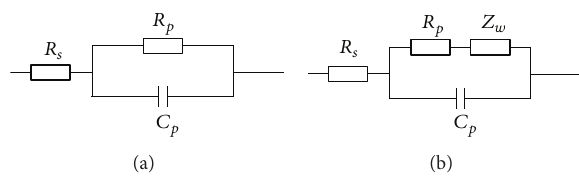
Figure 10: The equivalent circuit of sensors showing (a) a hopping mechanism and (b) an ion diffusion